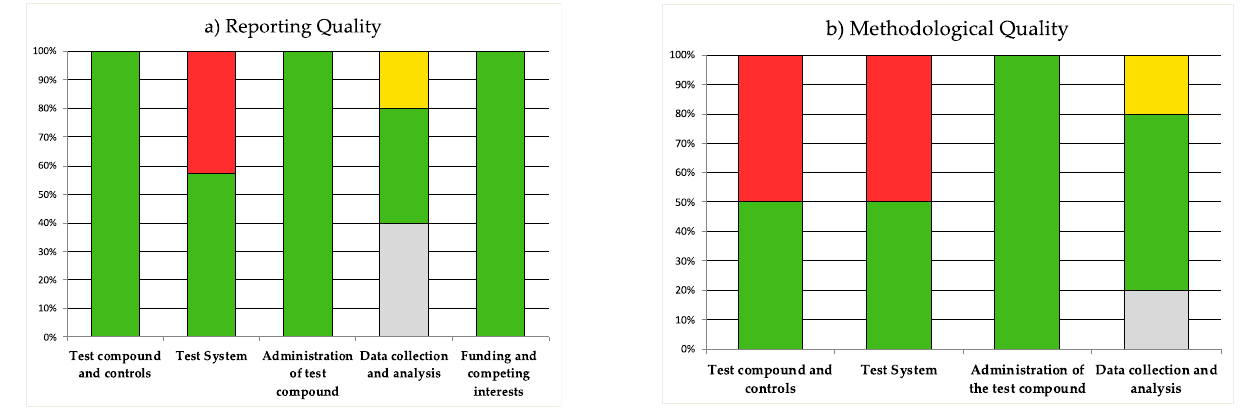
Figure 4. An example of a color profile generated with the SciRAP tool. In the color profile, the evaluation of ( a ) reporting quality and ( b ) methodological quality are illustrated in bar charts, showing green for fulfilled criteria, yellow for partially fulfilled criteria, and red for criteria that were not fulfilled.